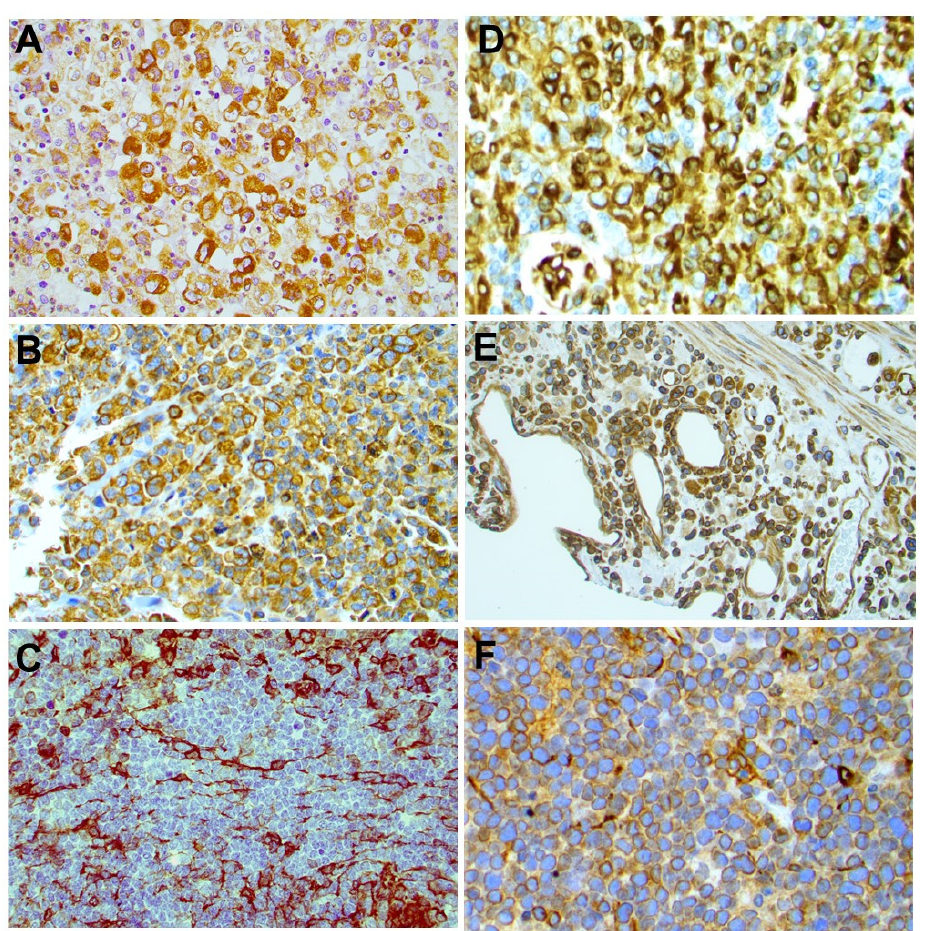
Figure 3. Expression of STING in different types of T-cell lymphomas. STING was differentially expressed among PTCL histological types. Representative examples of STING-positive ALK+ ALCL ( A ), ALK-ALCL ( B ), PTCL-NOS ( D ), NK/T-nasal type ( E ), and T-LBL ( F ) are shown. A representative STING-negative AILT case ( C ) is also shown. Original magnification ×400 ( A–D , F ) and ×200 ( E ). DAB as chromogen. Table 1. Expression of STING in B-cell and T-cell non-Hodgkin lymphomas. Lymphoma Type